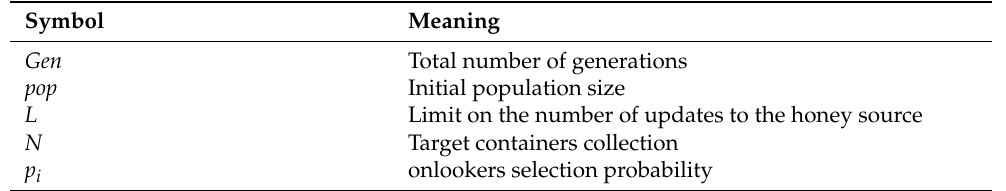
Table 1. Parameters of the IABC